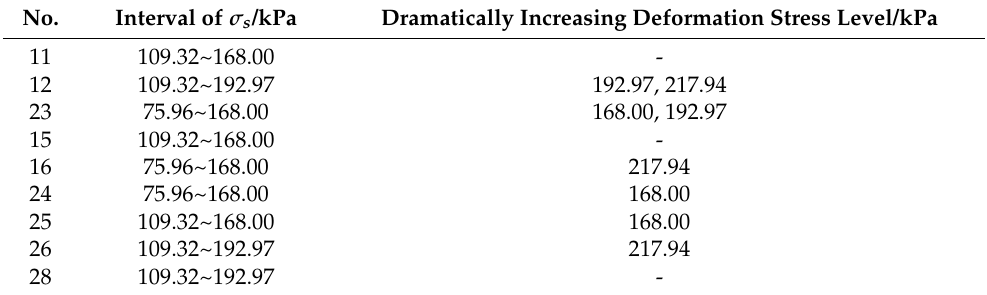
Table 4. Theyieldstressintervalanddramaticallyincreasingdeformationstresslevelofthecreepspecimens. No. Interval of σ s /kPa Dramatically Increasing Deformation Stress Level/kPa